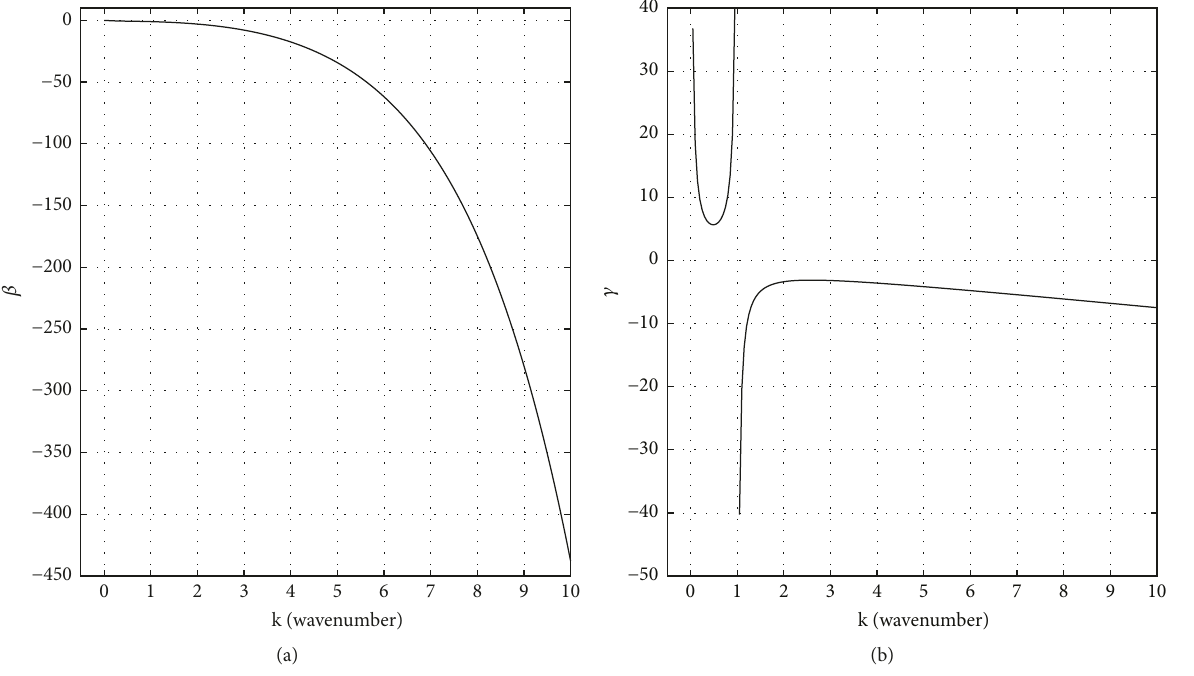
Figure 1: Graph of the value of dispersive coefficient 𝛽 (a) and nonlinear coefficient 𝛾 (b) with respect to wave number 𝑘 from NLS equation (4).